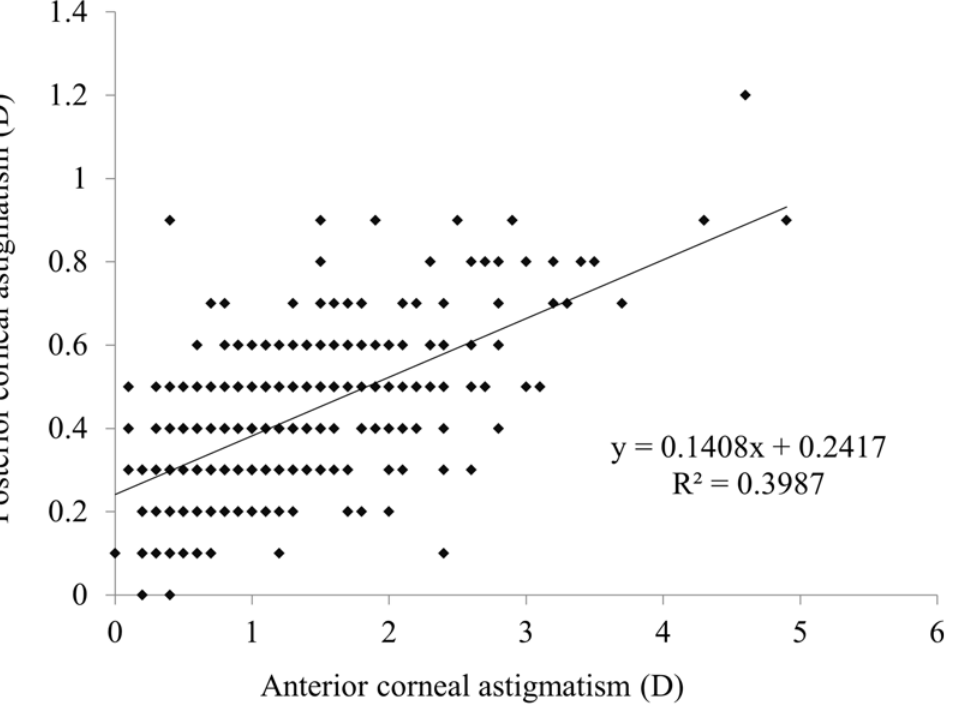
Fig 3. A graph showing a significant correlation between the magnitudes of anterior and posterior corneal astigmatism (Pearson correlation coefficient r = 0.5746, P < 0.001) in eyes with-the-rule (WTR) anterior corneal